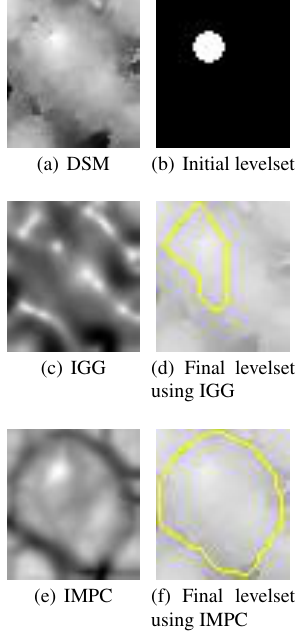
Figure 4. An example in favour of IGG.